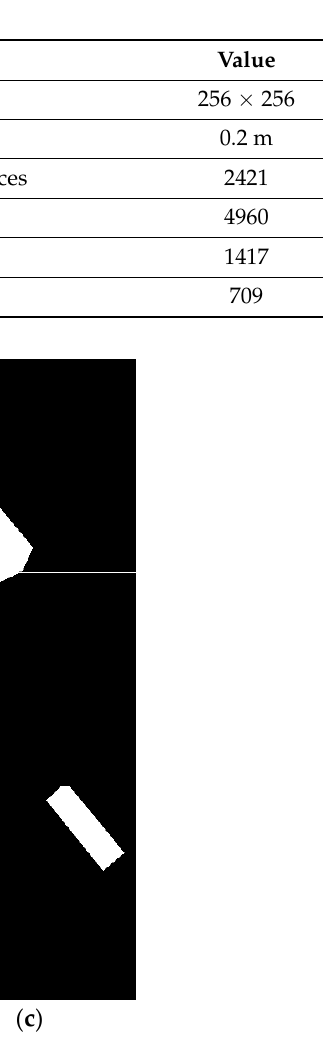
Figure 6. Two-phase images and change information of the WHU building dataset. ( a ) image1; ( b ) image2; ( c ) label.